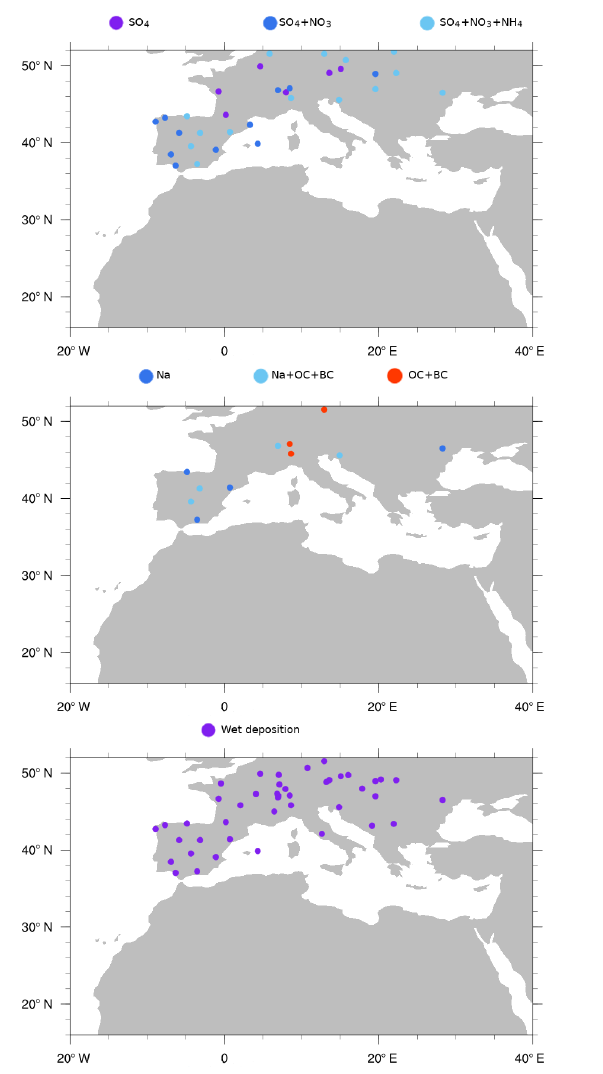
Figure 3. Location of the EMEP stations used in this study for the year 2013.